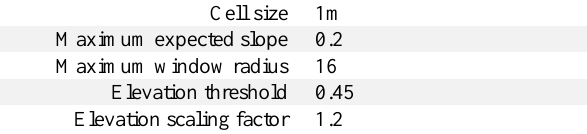
Table 1. SMRF algorithm parameters.